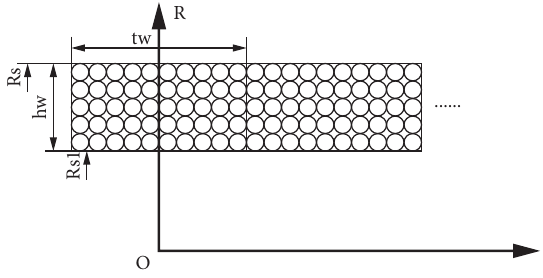
Figure 5: Schematic diagram of the